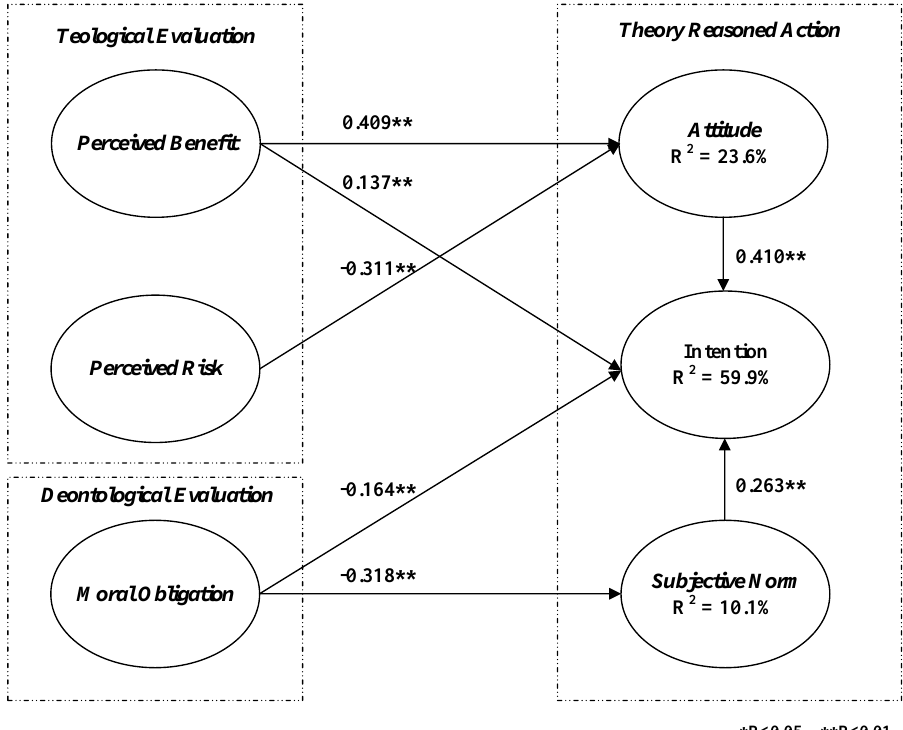
Fig. 2: Result of structural model; Source :